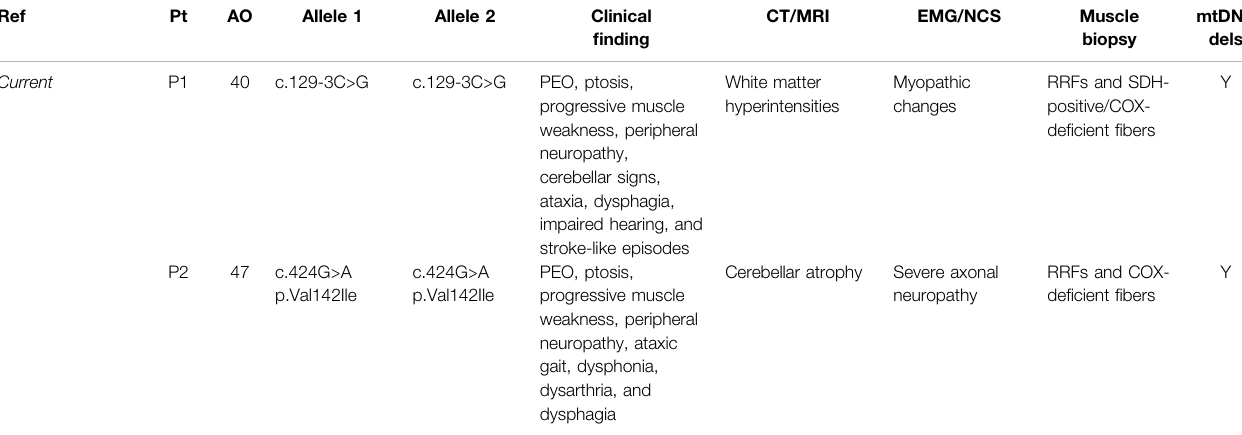
TABLE 1 | ( Continued ) List of RNASEH1 -mutated patients described so